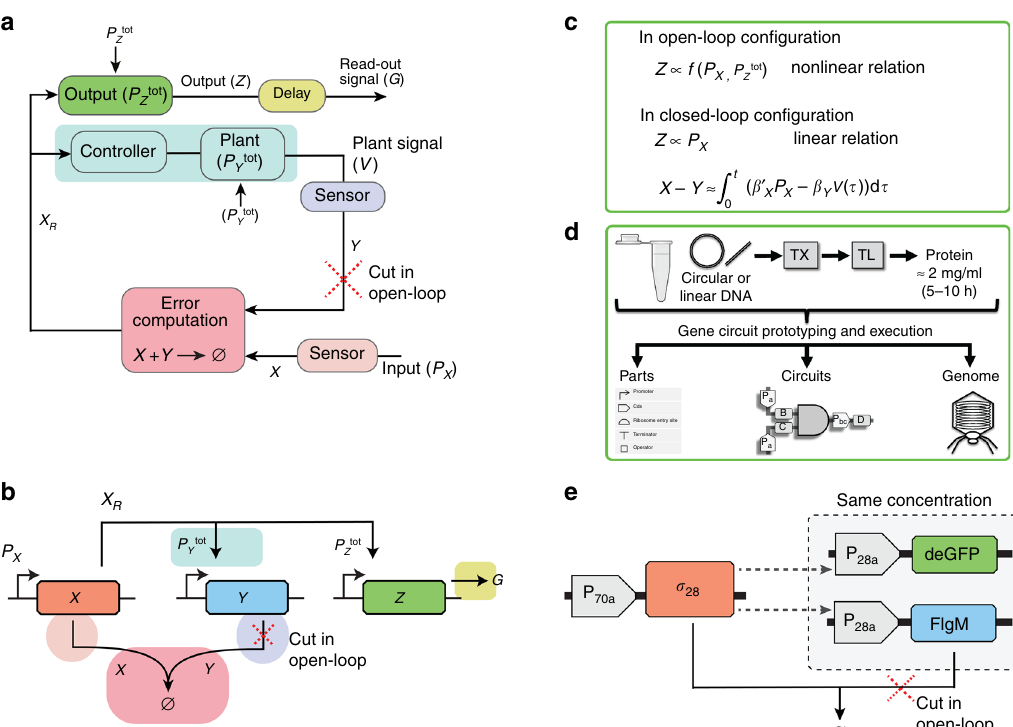
Fig. 1 The synthetic biological integral controller. a Block diagram of a typical closed-loop controller. b Design of the synthetic biological integral controller, where the color coding corresponds to the blocks shown in a . The reference is set by the input DNA P X and the plant signal V (mRNA of gene y ) is measured through the expression of another gene z , which encodes for a protein Z . Error computation is achieved through a molecular sequestration reaction between the proteins X and Y . Here the red-color cross represents the open-loop con fi guration of the controller, which results when the feedback signal Y is absent. c In the closed-loop con fi guration, the error criterion is the difference between scaled versions of the input P X and the plant signal to be regulated, V . In the actual controller implementation, this role is played by the free amount of the protein X , which we denote as X R because we think of it as what remains after binding to Y (and to promoter sites). To produce an output ( Z ) that is independent of the disturbances in P tot Y and P tot Z , the error signal is integrated (see Supplementary Note 1). The assumptions made to derive this expression are mentioned in Supplementary Note 1 where it is also shown that the controller output ( Z ) linearly depends on the plant signal at the steady state. In the absence of the feedback the output depends nonlinearly on P X and P tot Z such that any disturbance in P tot Z may perturb the output. d Overview of the E. coli cell-free toolbox for prototyping and executing parts and circuits in vitro. e Experimental implementation of the integral controller. Three plasmids are used, P 70a - σ 28 , expressing the E. coli σ 28 ( X ) from a σ 70 promoter ( P X ), P 28a -FlgM, expressing the anti- σ 28 factor ( Y ) from a σ 28 promoter ð P tot Y Þ , and P 28a -deGFP, expressing the reporter deGFP ( G ) from a σ 28 promoter ð P tot Z Þ . In the open-loop controller, instead of the anti- σ 28 factor (FlgM), mSA is expressed, which is not sequestered by σ 28 , nor does it directly affect any reaction rates (see Methods). The mSA control gene promoter is denoted as P tot YC